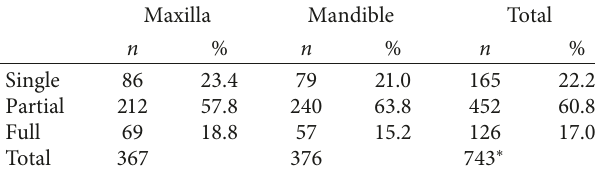
Table 5: Number of implants per type of